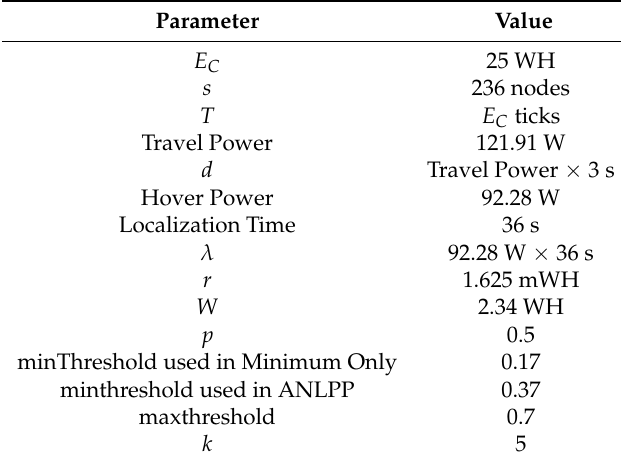
Table 2. Network configuration